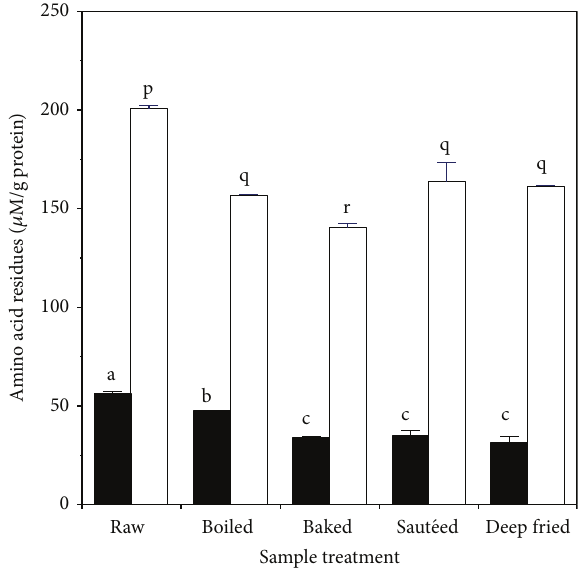
Figure 4: Effect of heating on content of iron-binding amino acid residues in chicken muscle: ◼ total sulfhydryl; ◻ total histidine. Values are the mean ± standard deviation ( 𝑛 = 6 ). Means in the same group ( ◼ or ◻ ) without a common letter differ at 𝑃 < 0.05 .